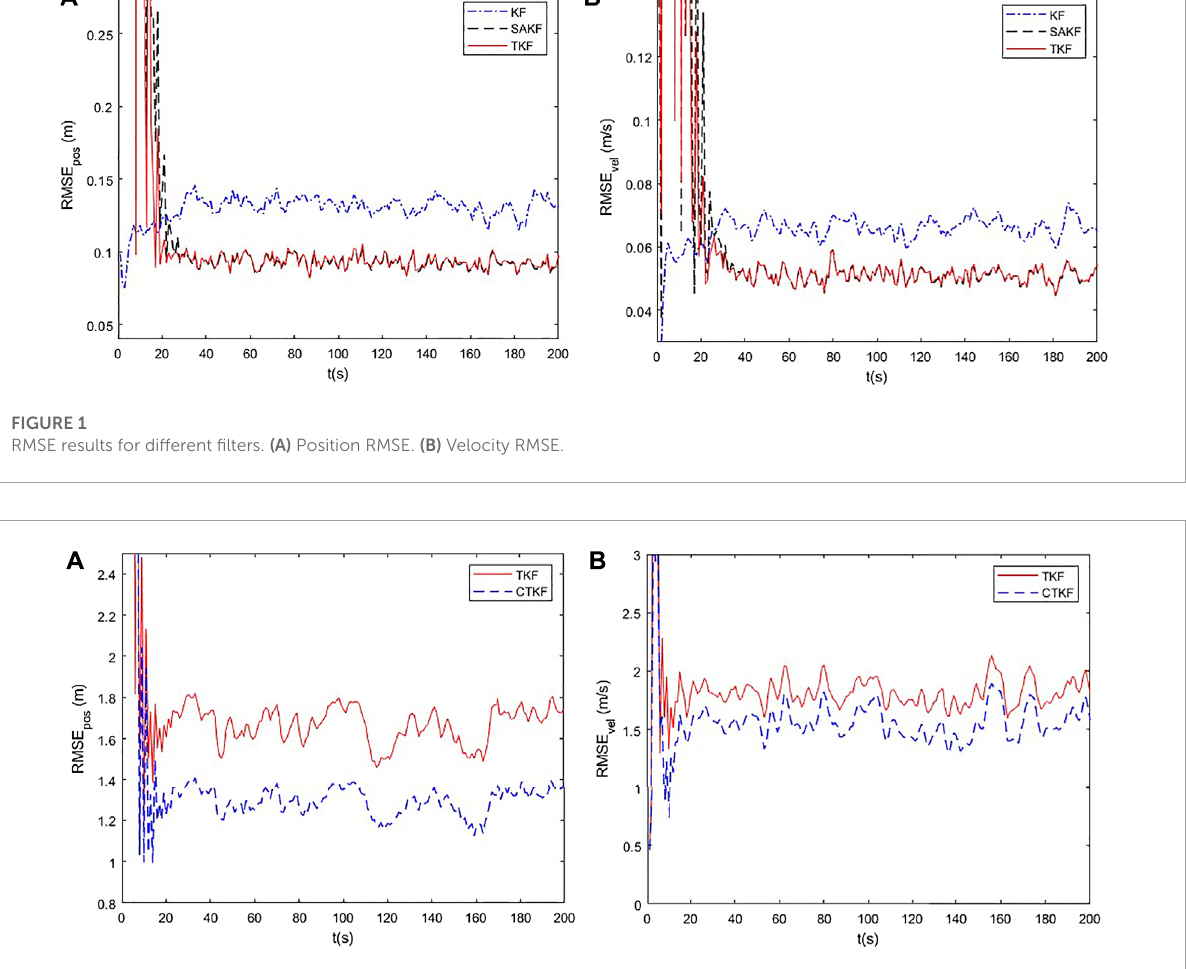
FIGURE 2 RMSE results for different filters. (A) Position RMSE. (B) Velocity